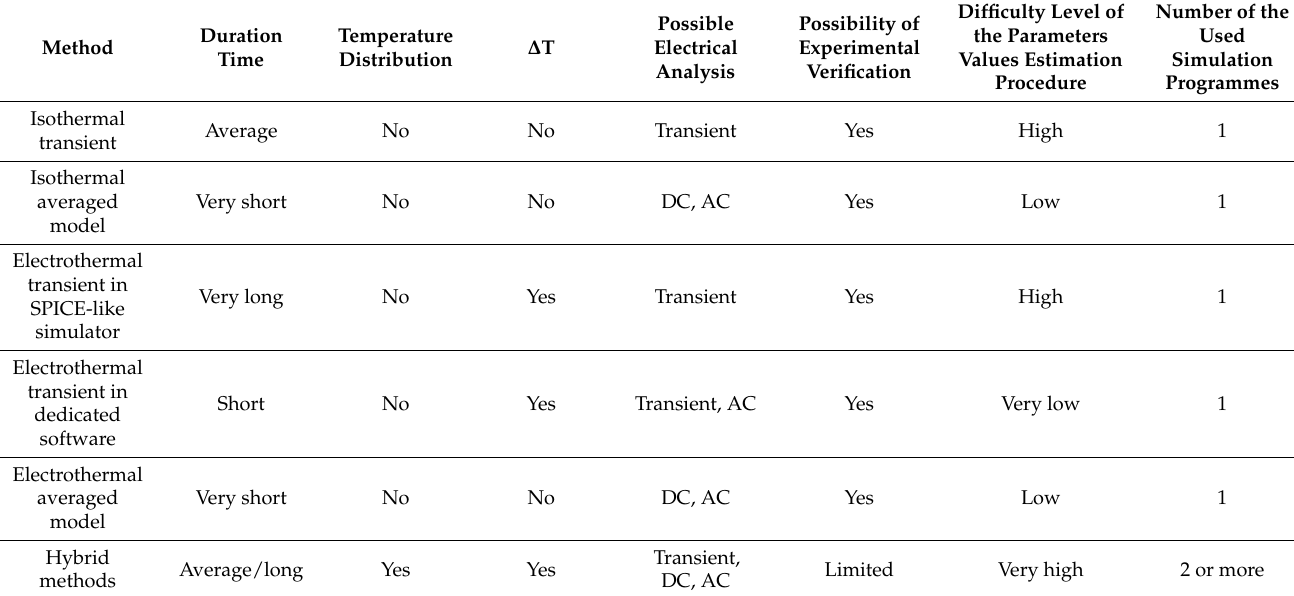
Table 5. Summary of the most important properties of the analysed methods of the analysis of DC–DC converters. Method